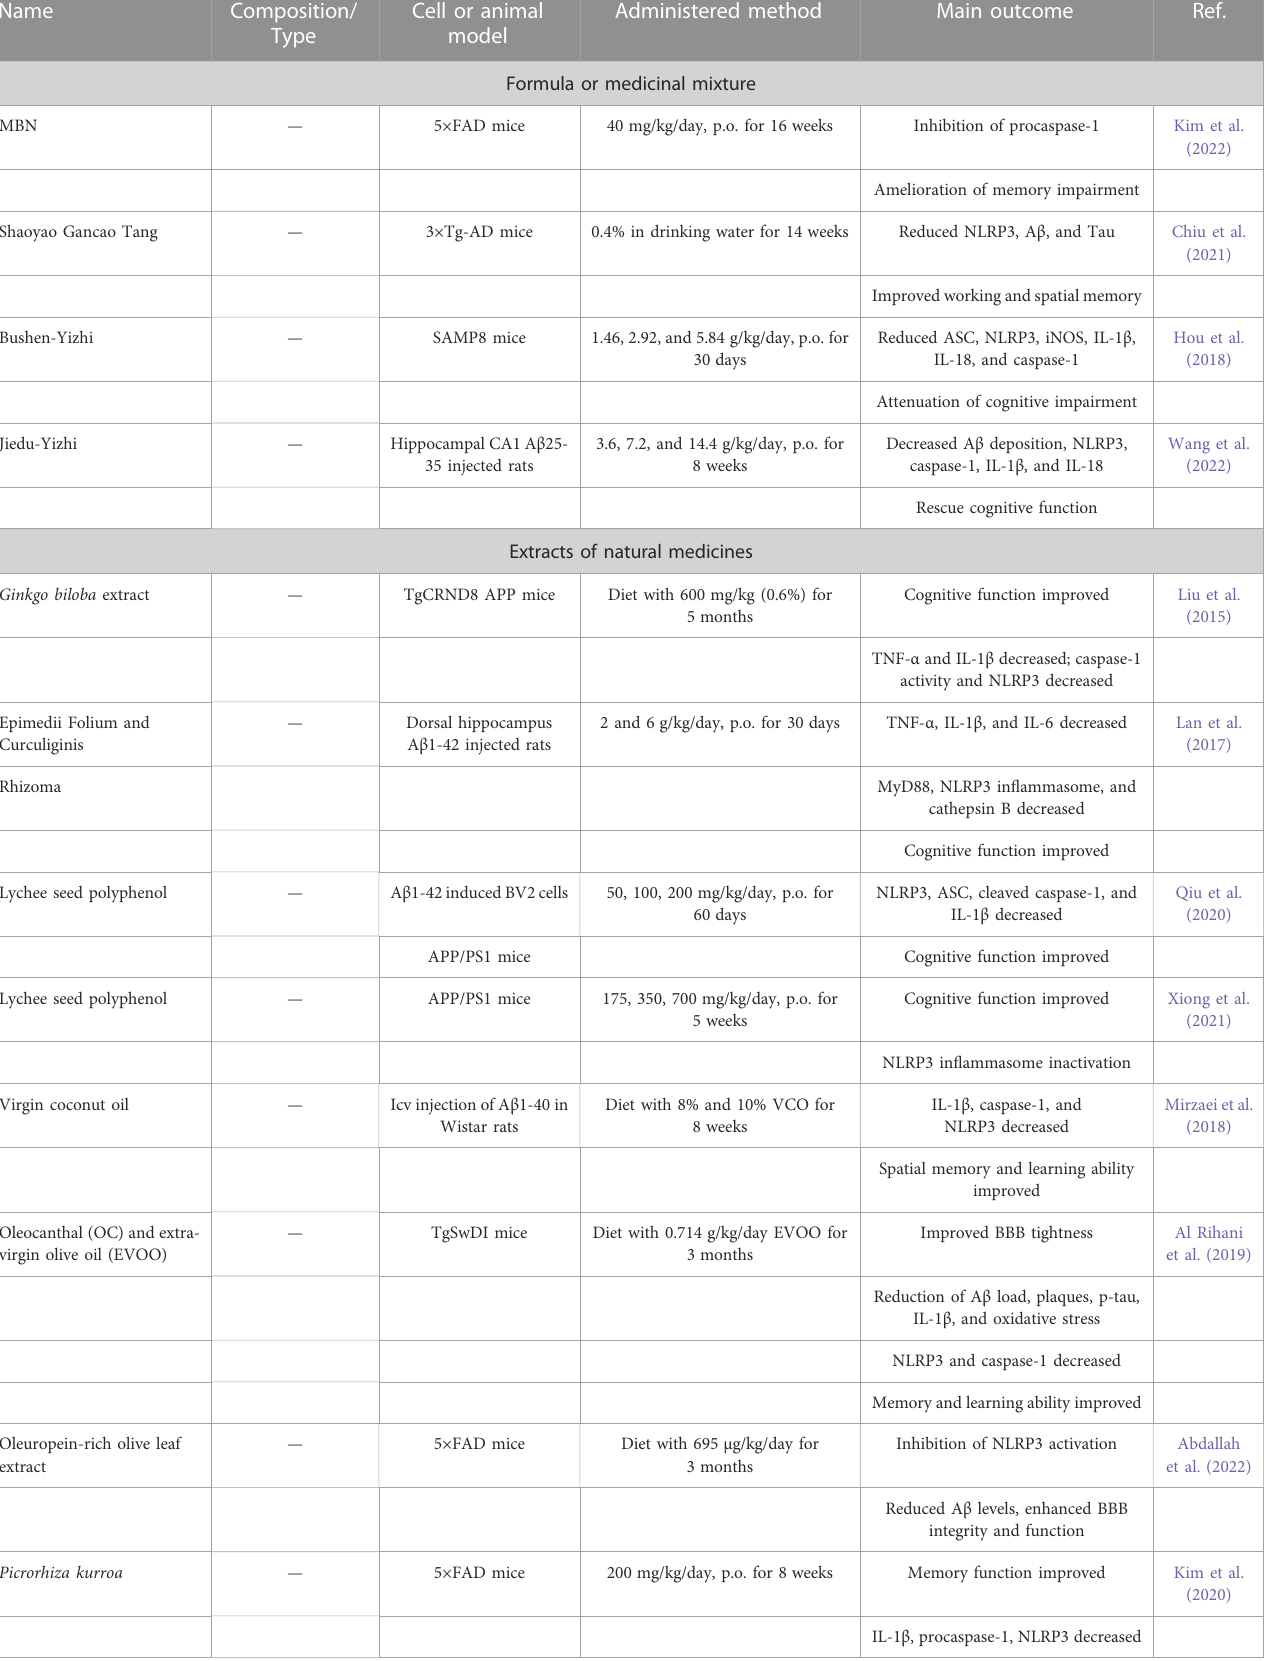
TABLE 1 Formula, medicinal mixture, extracts, and natural occurring compounds for AD treatment by targeting NLRP3 in fl ammasome.